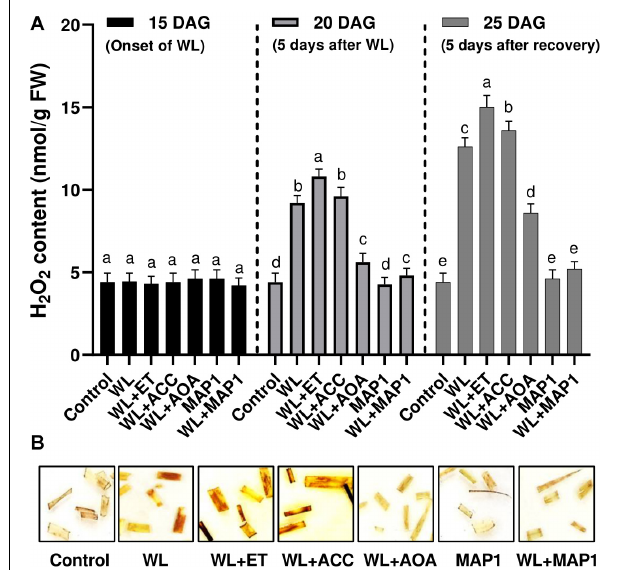
FIGURE 5 | Effect of WS on (A) H 2 O 2 production in wheat plants with and without MAP1 inoculation, exposed to WS. Quantitative data represent means ± SD of three independent experiments and at least 10 technical replicates each. (B) DAB staining using 1 cm-long segments of the 3rd leaf from 25-day-old seedlings with and without MAP1 inoculation. Different letters indicate statistically significant differences between treatments ( p ≤ 0.05,